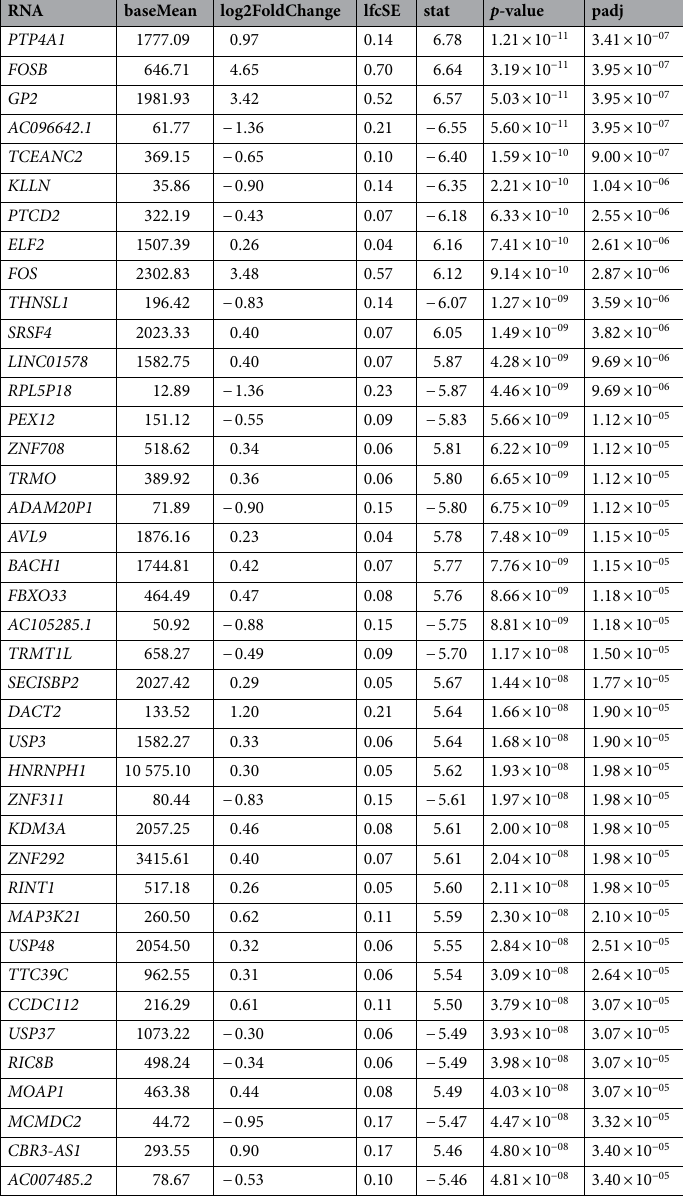
Table 3. The 40 top differentially expressed genes (DEGs) in non-polyp nasal epithelial mucosa from patients with CRSwNP versus mucosal tissue from controls. The mRNA levels (baseMean) of expressed genes and p-values adjusted using the Benjamini–Hochberg method. BaseMean mean RNA count, lfcSE log2 Fold Change Standard Error, stat Wald statistic Z-score, padj p -value